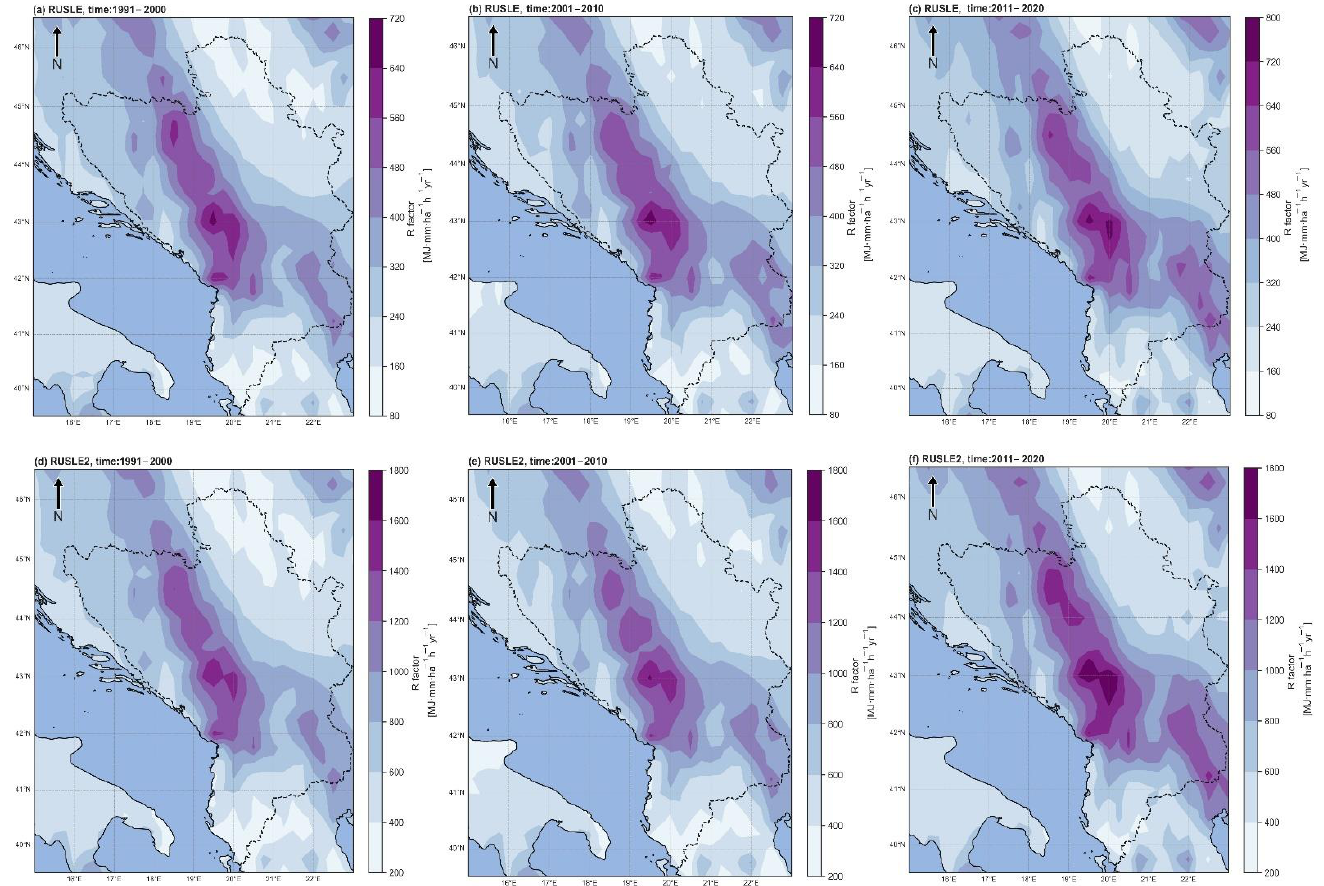
Figure 7. R-factor calculated using the RUSLE ( a – c ) and RUSLE2 ( d – f ) methodologies. The RUSLE methodology shows that the mean R-factor is unchanged between the 1990s and the 2000s (respectively 310 MJ mm ha − 1 h − 1 yr − 1 to 320 MJ mm ha − 1 h − 1 yr − 1 ) but increases in the 2010s to 360 mm ha − 1 h − 1 yr − 1 . The same trend is seen in the median (50th percentile): from around 290 MJ mm ha − 1 h − 1 yr − 1 in the 1990s and the 2000s to 330 MJ mm ha − 1 h − 1 yr − 1 in the 2010 s. Maximum values >680 MJ mm ha − 1 h − 1 yr −